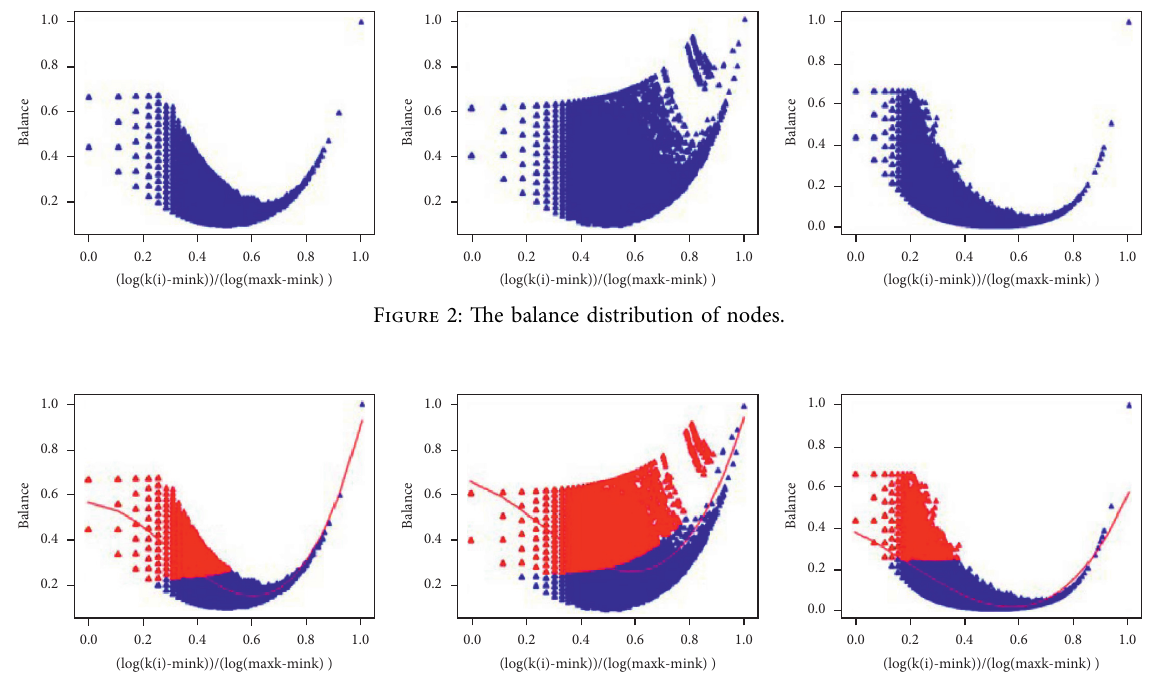
Figure 3: Nodes with high node density (with red